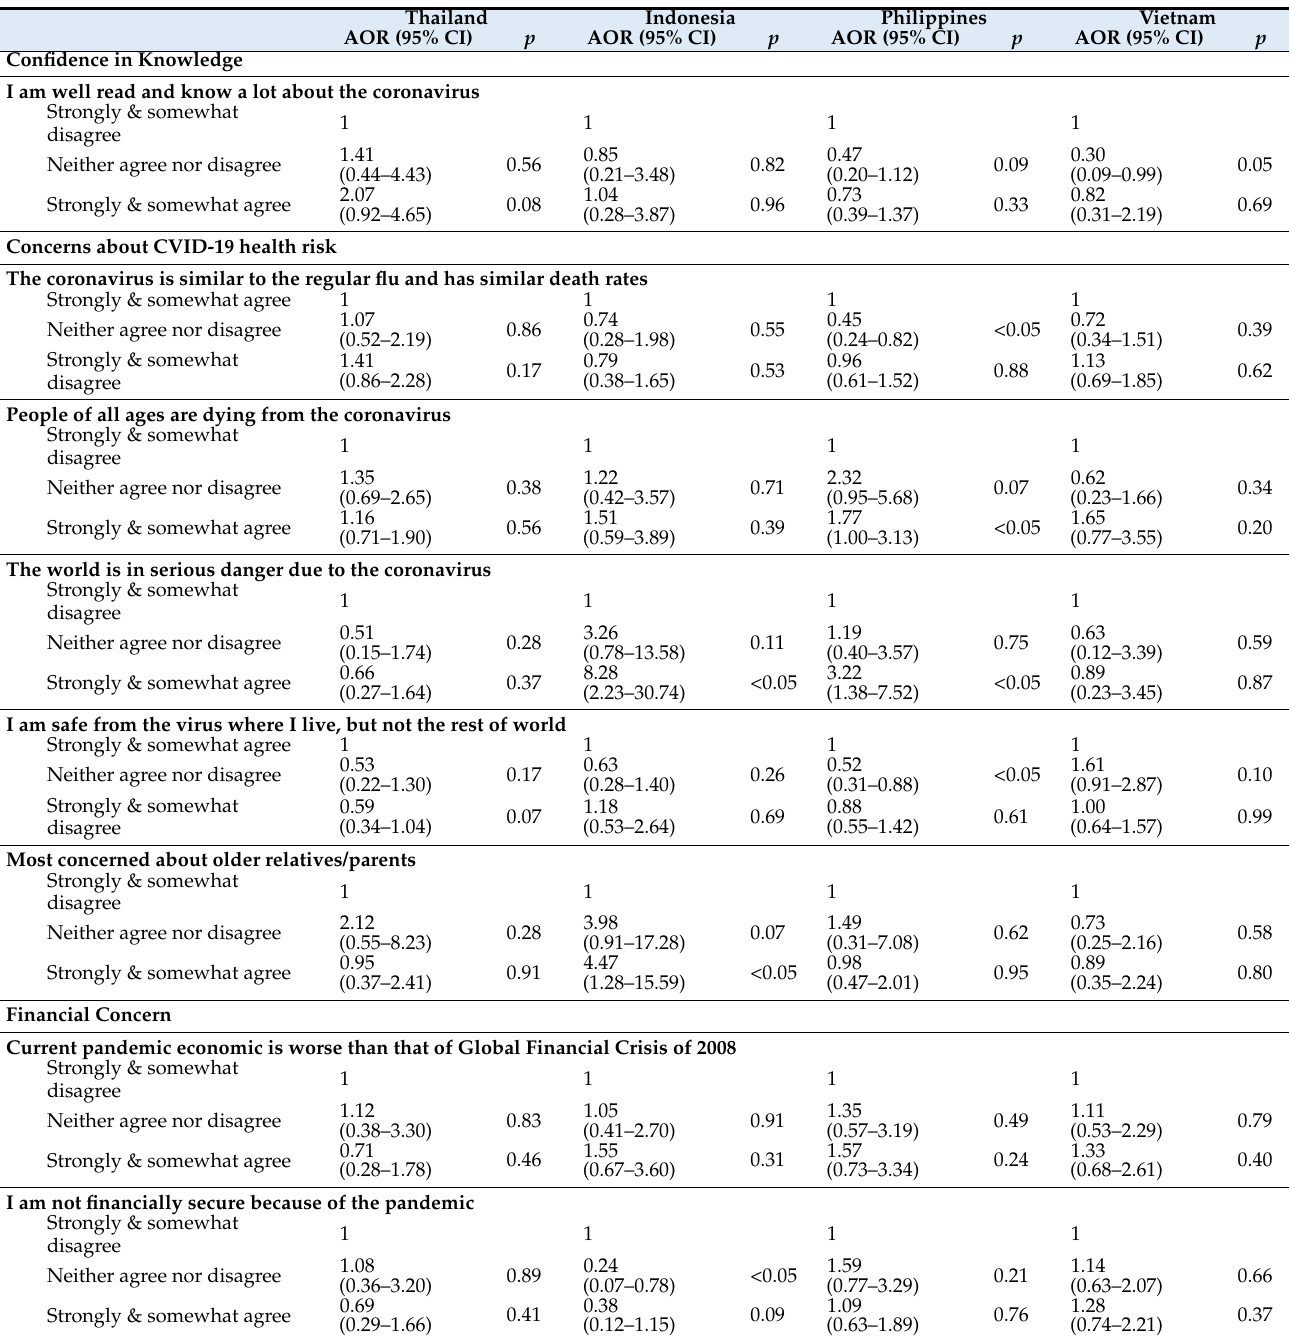
Table 9. Binomial logistic regression of willingness for vaccine with virus